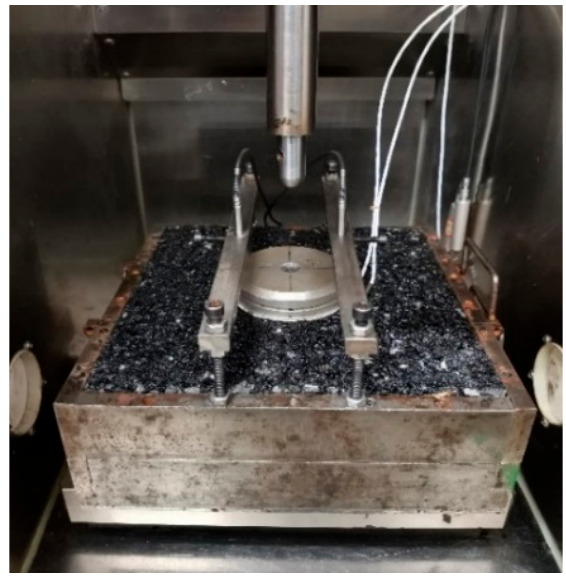
Figure 3. Setup of the confined dynamic modulus test.